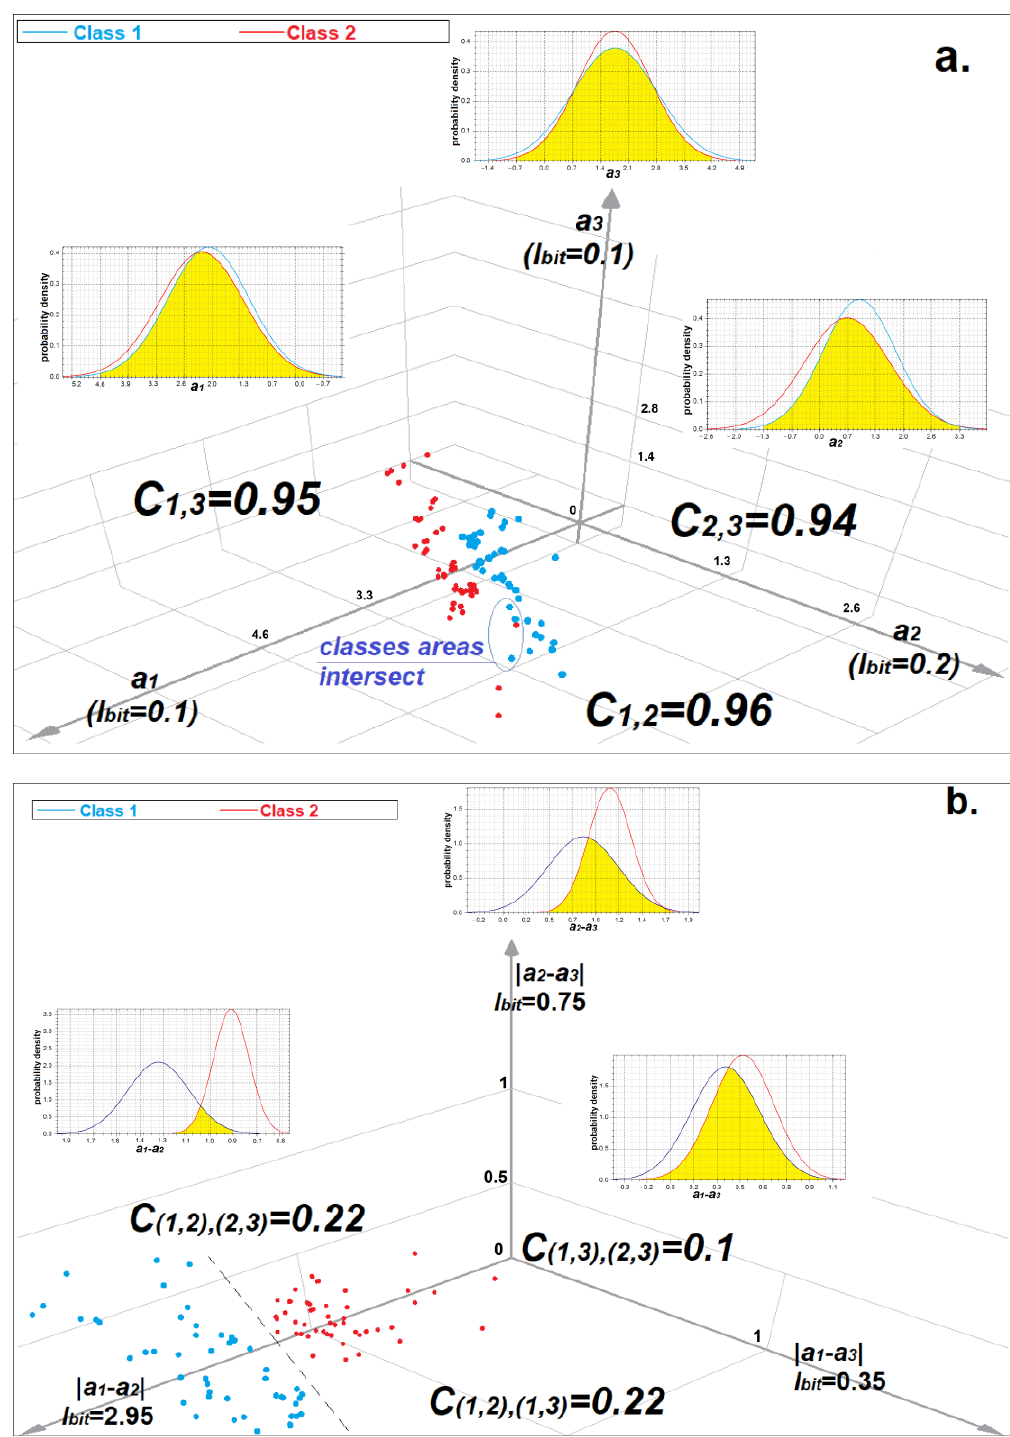
Figure 5. Spaces of three features (meta-features) and plots of the probability densities of their values: ( a ) the initial space of positively correlated features; ( b ) space of Bayes–Minkowski meta-features derived from the initial feature space by applying mapping (12) with p = 1.